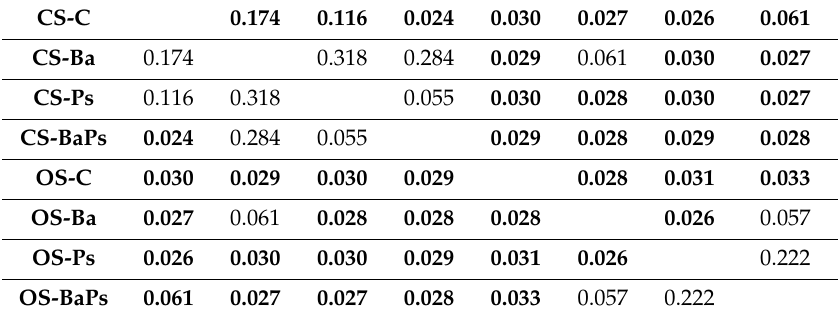
Table 2. Results of ANOSIM analysis ( p -values) based on the similarity index of Bray-Curtis applied to the data of individual PLFAs. The numbers in bold ( p < 0.05) indicate statistically significant di ff erences (the first symbol is the acronym for the management system (CS: Conventional system; OS: Organic system) and the second symbol corresponds to the inoculum type; Ba: B. subtilis ; Ps: P. fluorescens ; BaPs: Both inoculants; C: